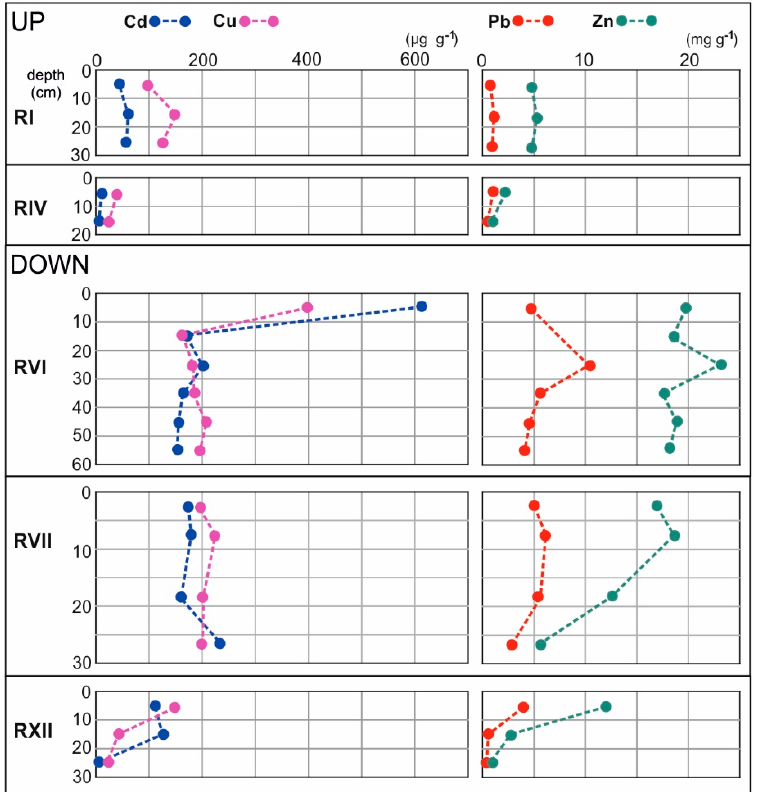
Figure 2. Heavy metal concentrations in the sediment cores in subsidence ponds (UP: Subsidence pond formed after the closure of the mine; cores: RI, RIV; DOWN: Subsidence ponds formed during peak of exploitation; cores: RVI, RVII, RXII).